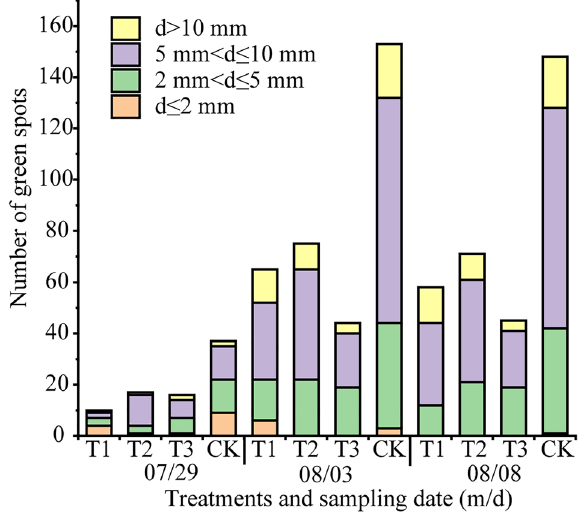
Figure 1. Changes in the number and size of green spots on tobacco leaves in different treatments during the air-curing period. T1 (0.1 M sucrose), T2 (0.2 M sucrose), T3 (0.4 M sucrose) and CK (pure water). Values are the number of green spots in a total of 9 tobacco